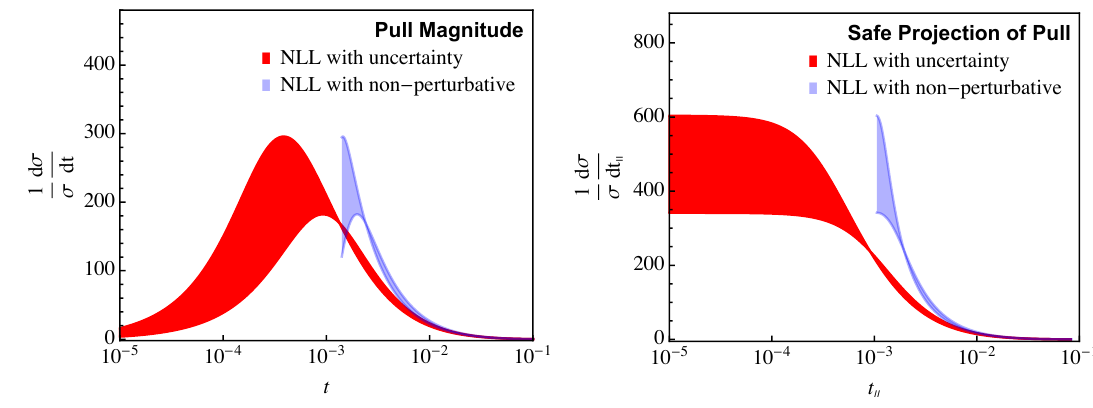
Figure 3 . Plots of the NLL predictions for t (left) and t theoretical uncertainties, obtained by varying the renormalisation scale. The plots also show how the curve is modify once the shift due to non-perturbative corrections is